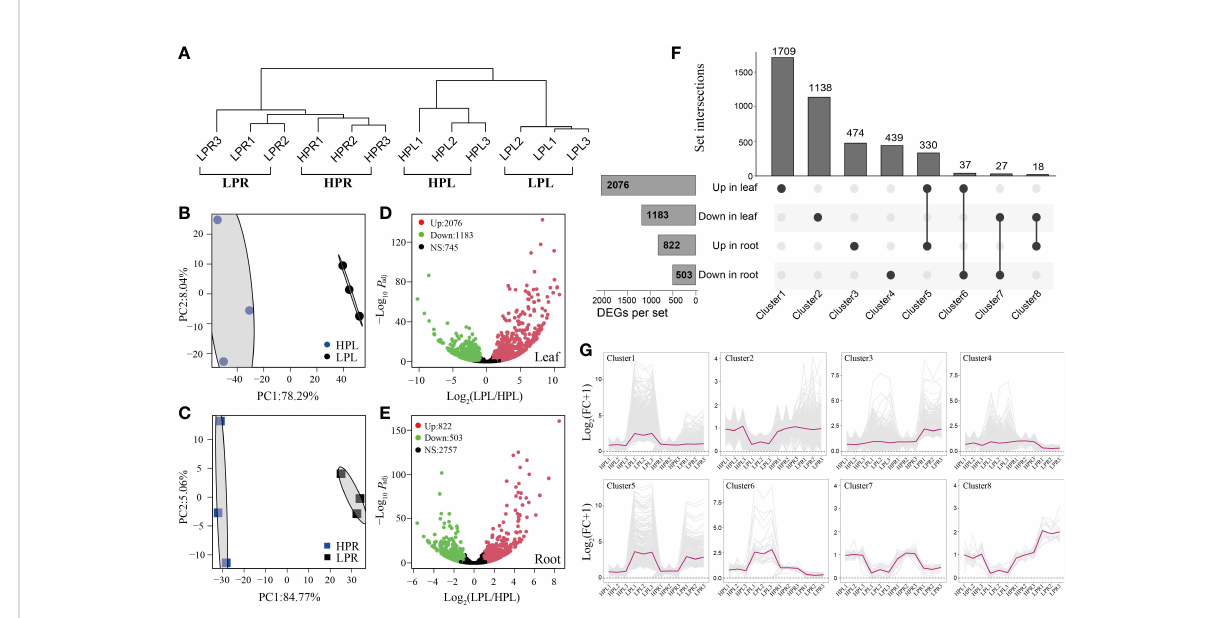
FIGURE 2 Overview of differentially expressed unigenes (DEGs) in the transcriptome of elephant grass. (A) Hierarchical clustering of all samples based on expressed genes in the transcriptome. (B, C) Principal component analysis of all expressed unigenes in leaves (B) and roots (C) . (D, E) Volcano diagrams of distribution of unigenes in Pi-de fi cient leaves (D) and roots (E) . (F) Speci fi c and overlapping DEGs in Pi-de fi cient leaves and roots. (G) The differential expression patterns of DEGs in Clusters 1 – 8. The fold change of each unigene was normalized to the mean generated with all HP samples. LPL and LPR represent, respectively, leaves and roots treated with 0 m mol/L KH 2 PO 4 . HPL and HPR represent, respectively, leaves and roots treated with 600 m mol/L KH 2 PO 4 , the same as